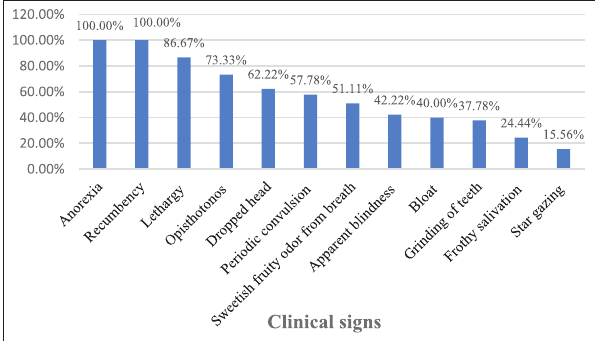
Figure-2: Clinical findings in pregnancy toxemic goats. normal healthy goats (Table-1). The mean values of SGPT (IU/L), SGOT (IU/L), glucose